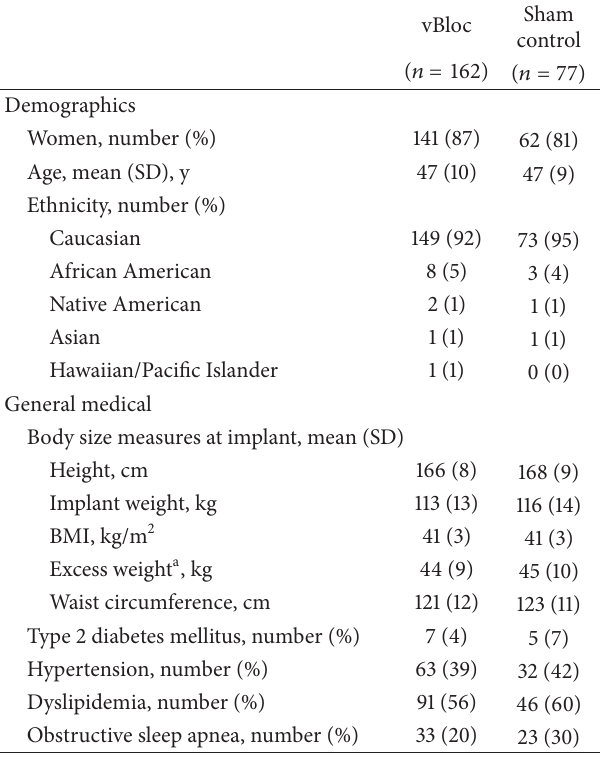
Table 1: Baseline characteristics by treatment group. Table 2: Mean %EWL and %TWL at 12, 15, and 18 months in ITT